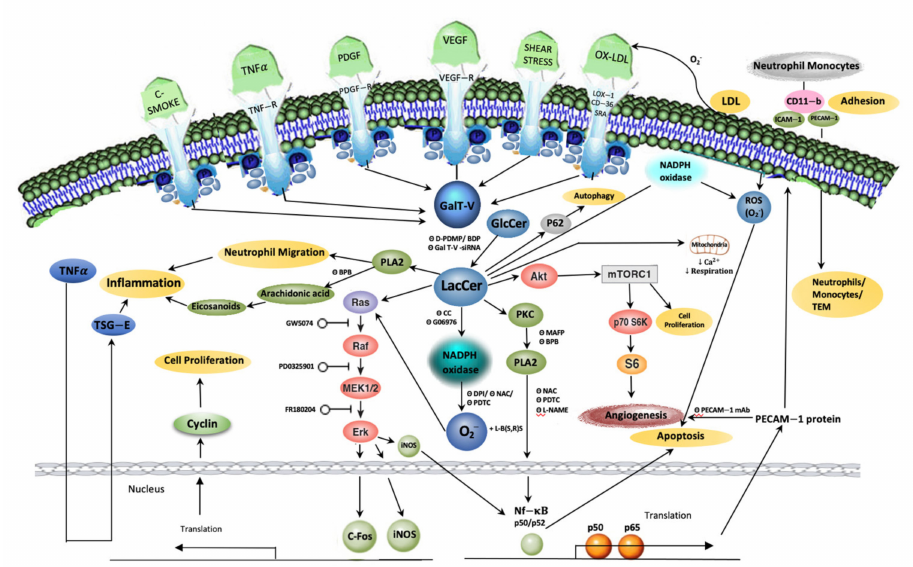
Figure 2. Schema of lactosylceramide-centric signaling pathways in the regulation of multiple phenotypes. Diverse agonists converge upon lactosylceramide (LacCer) synthase to generate LacCer. In turn, LacCer creates an “oxidative stress” environment by way of generating reactive oxygen species (ROS)/superoxides. LacCer also activates cytosolic phospholipase A2 (cPLA2) to generate arachidonic acid, a precursor to prostaglandins. Collectively, induction of these two signaling pathways contribute to diverse phenotypes: inflammation, cell proliferation, migration/infiltration, adhesion, angiogenesis apoptosis, autophagy, and mitochondrial